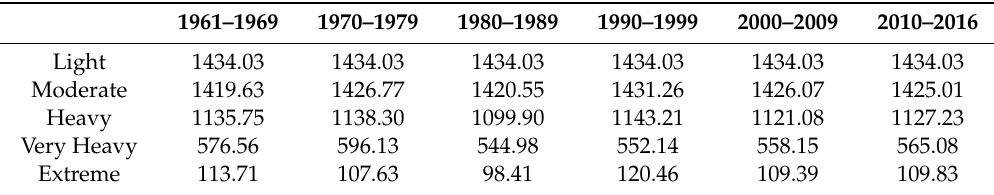
Figure 8. Interannual variation of precipitation cover area for each grade. Table 4. Interannual variation of precipitation cover area for each grade.